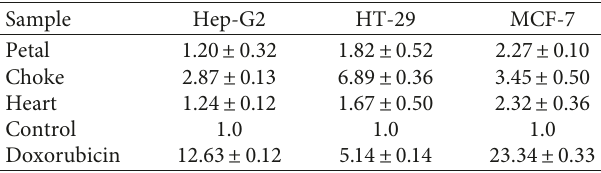
Table 6: Caspase-3 activity in Hep-G2, HT-29, and MCF-7 cells after incubation with a petal, choke, and heart of C. scolymus L. head.